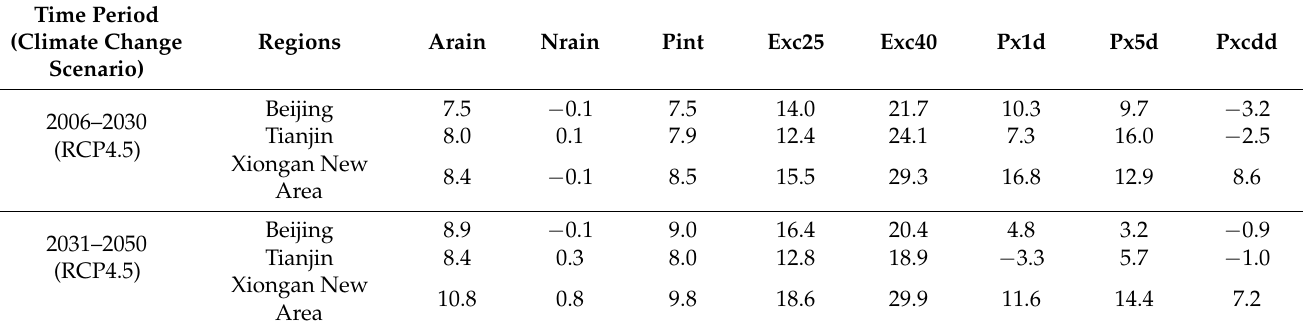
Figure 3. Spatial distribution of annual percentage changes in Pint across the Beijing-Tianjin-Hebei region during 2006–2030, 2031–2050, and 2051–2070, compared with 1961–2005. Table 4. Regional average percentage changes in the eight precipitation indices during the future three periods in the Beijing, Tianjin, and Xiongan New Area (unit: